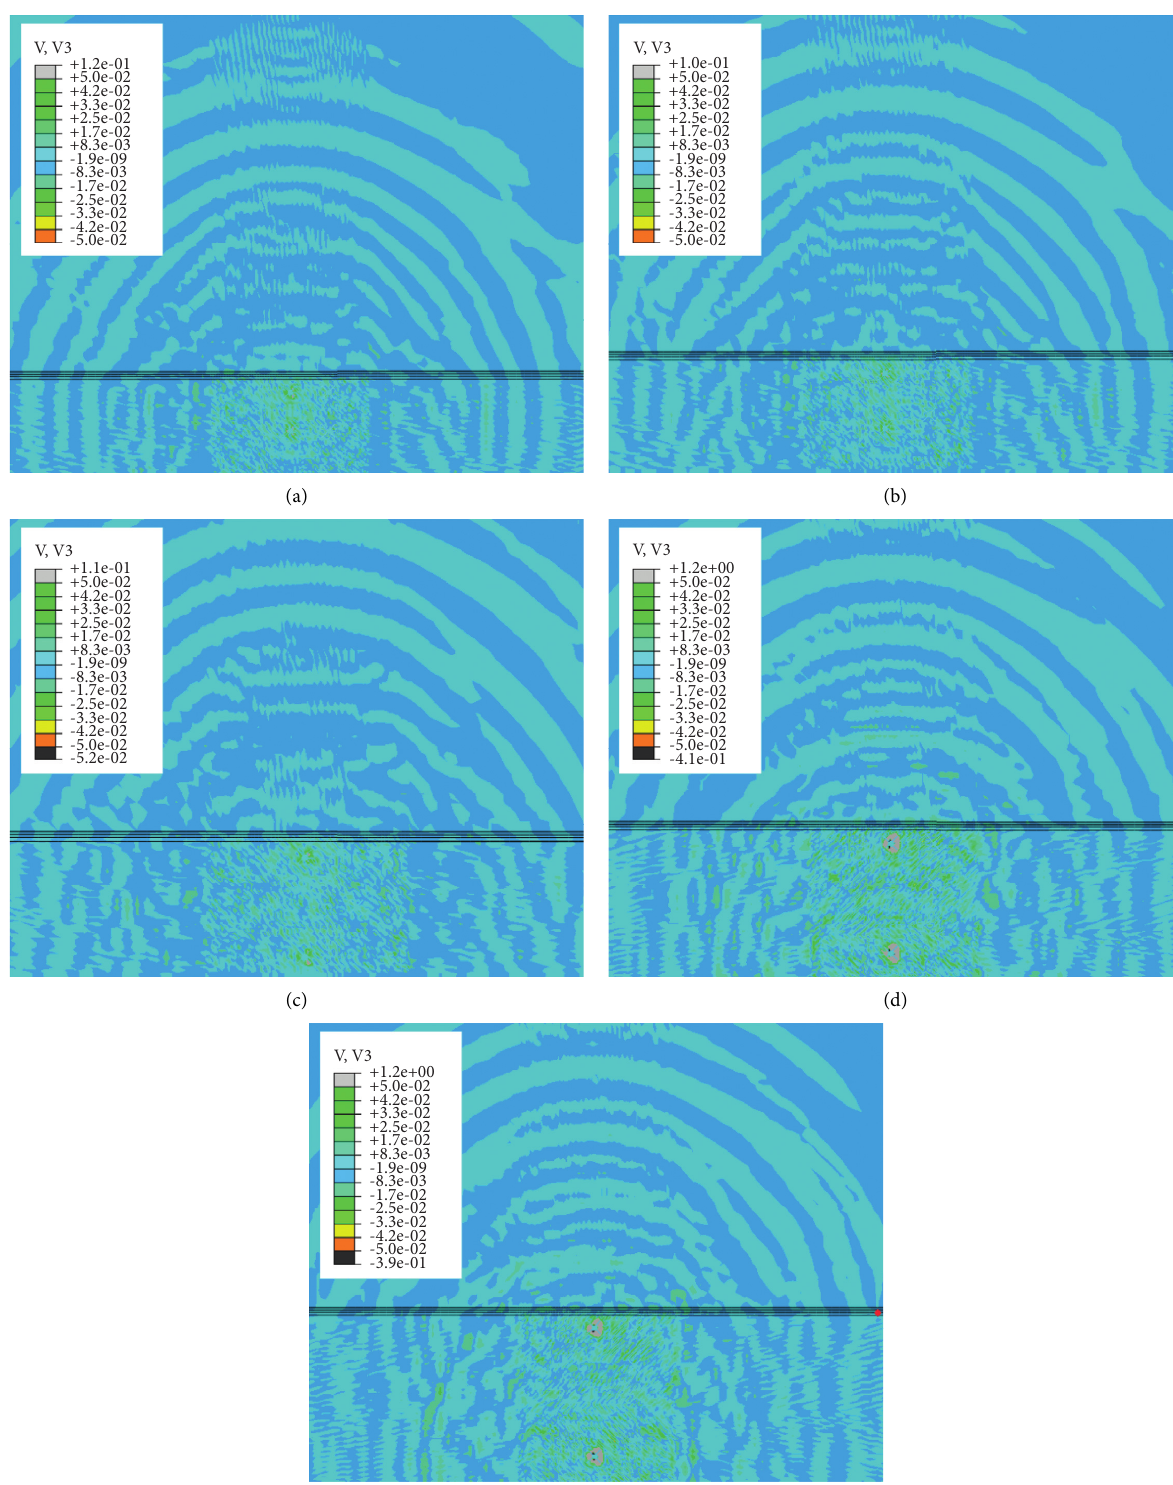
Figure 9: Comparison of the cloud plots of the peak vertical vibration velocities at different measurement points with different distances between the two hammers (m/s; for the vertical arrangement): (a) two hammer distances of 15m, (b) two hammer distances of 20 m, (c) two hammer distances of 30m, (d) two hammer distances of 40 m, and (e) two hammer distances of